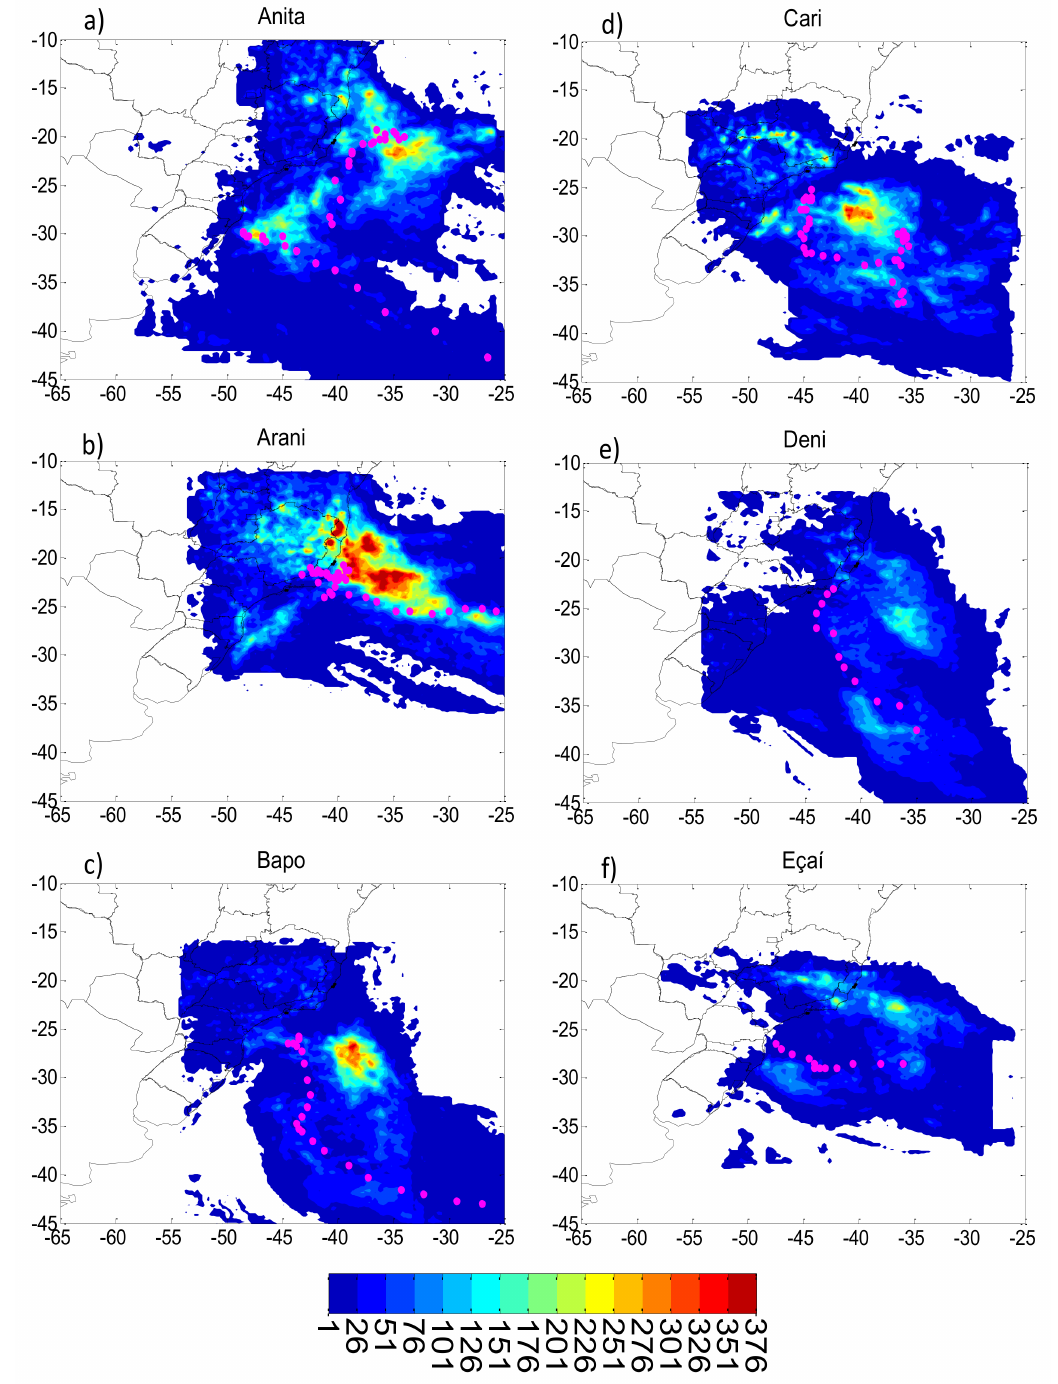
Figure 10. Accumulated precipitation (mm) during the lifecycle of the subtropical cyclones: ( a ) Anita, ( b ) Arani, ( c ) Bapo, ( d ) Cari, ( e ) Deni and ( f ) Eça í . Circles in pink color indicate the cyclone position every 6